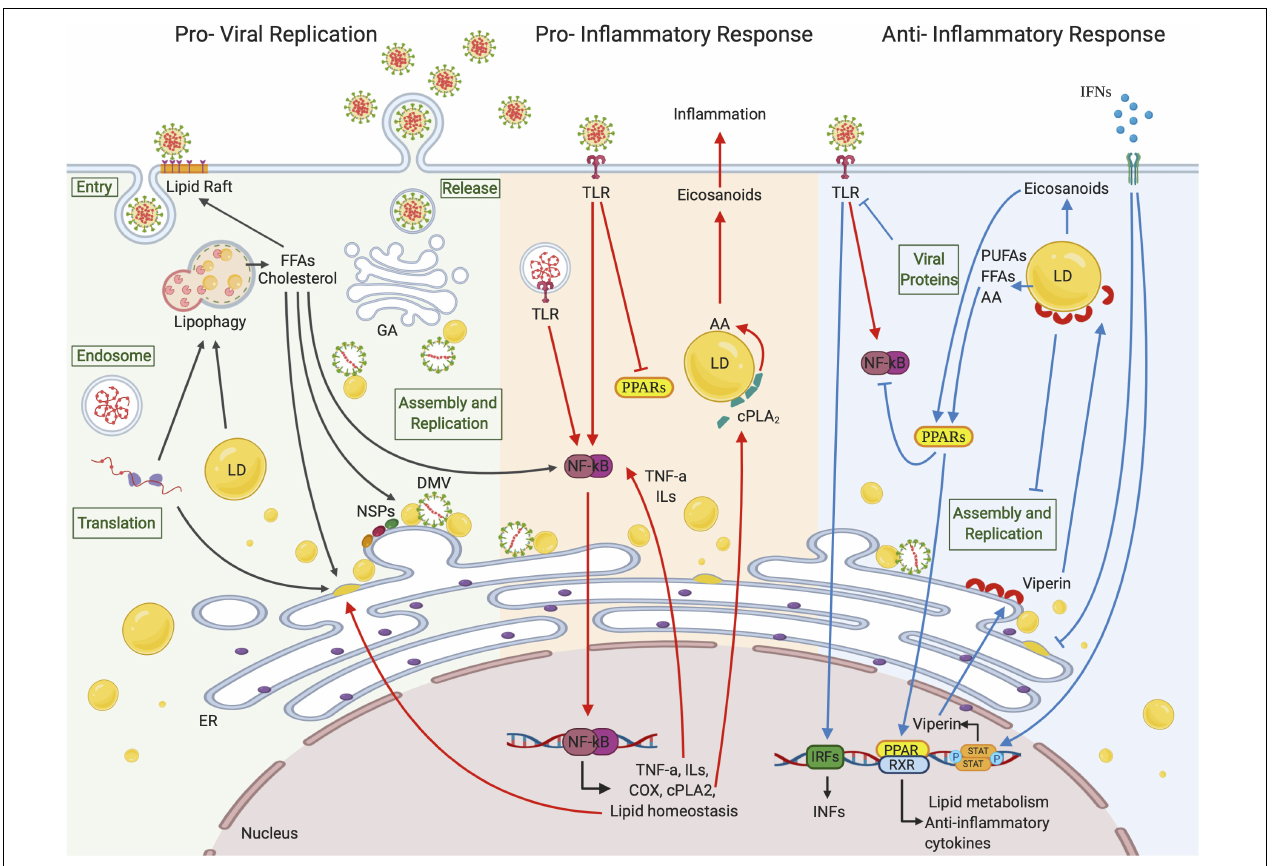
FIGURE 2 | Lipid droplets involvement in (+)ssRNA virus infections. LDs seem to be involved in all the (+)ssRNA virus infection stages. During the first steps of a virus life cycle, thanks to a tight connection with ER vesicles and DMVs, LDs can serve as a platform for virus replication and assembly. LDs are also involved in the inflammation responses. Once viral signatures activate TLRs, an immune signaling cascade is initiated through the activation of the NF- κ B pathway leading to the expression of downstream target genes. FFAs generated from LD metabolism rearrangement can also function as activating stimuli to NF- κ B itself. cPLA2 α localizes on the LD surface where it releases AA, which is converted in eicosanoids supporting inflammation. On the other side, LDs can hinder inflammation by activating PPAR anti-inflammatory signaling pathways or blocking virus replication and assembly through viperin, which localizes on LD surface. Created with